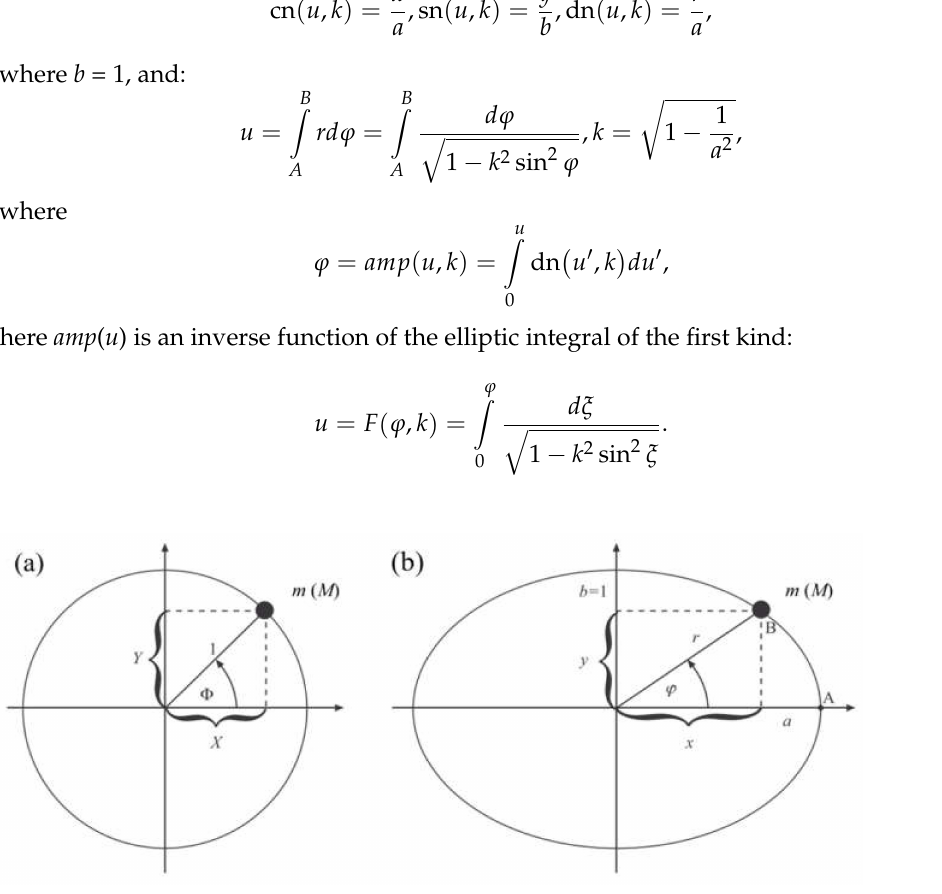
Figure 2. Geometrical representation of the oscillatory motion of the center of inertia of the rotor and the foundation: ( a )—Linear Case, ( b )—Nonlinear